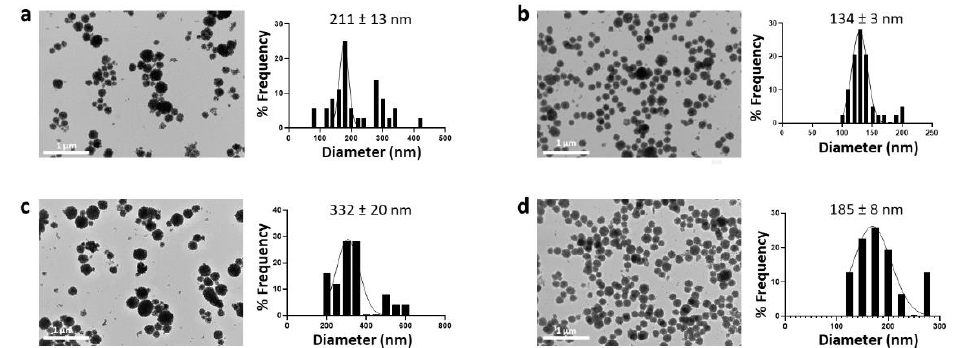
Figure 7. TEM images and size distribution of CaCO 3 NPs prepared at 4 °C varying the salt concen- tration (0.05 ( a , c ) and 0.025 M ( b , d )) and the reaction time (20 h ( a , b ) and 24 h ( c , d )).